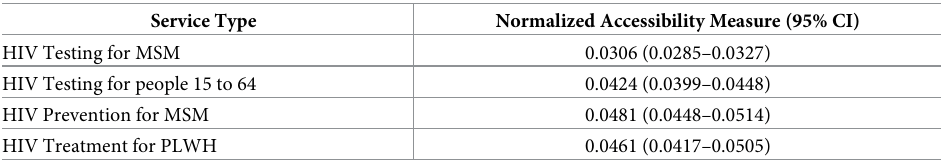
Table 3. Accessibility measure in